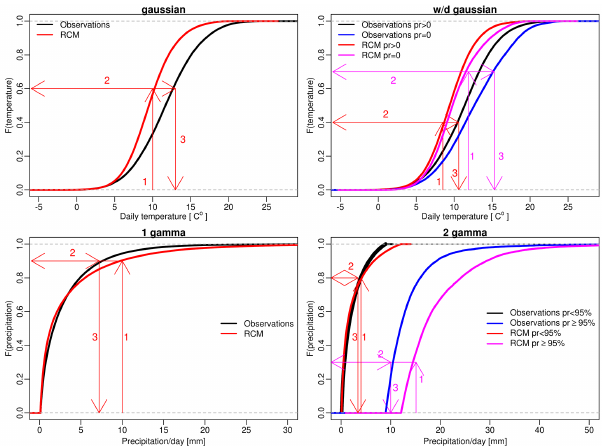
Figure 3. Procedure of the distribution based mapping. Upper panels for temperature adjustment and lower panels for precipita- tion (pr) adjustment. For temperature, Gaussian adjustment without wet–dry state separation (left) and with wet–dry separation (right) is shown. For precipitation, gamma adjustment with single gamma (left) and double gamma divided at 95th percentile (right) is shown. (1) Locate the cumulative probability value of RCM simulated daily temperature/precipitation. (2) Locate the observed tempera- ture/precipitation value corresponding the same cumulative proba- bility value as in (1). (3) This value is used as corrected value for RCM